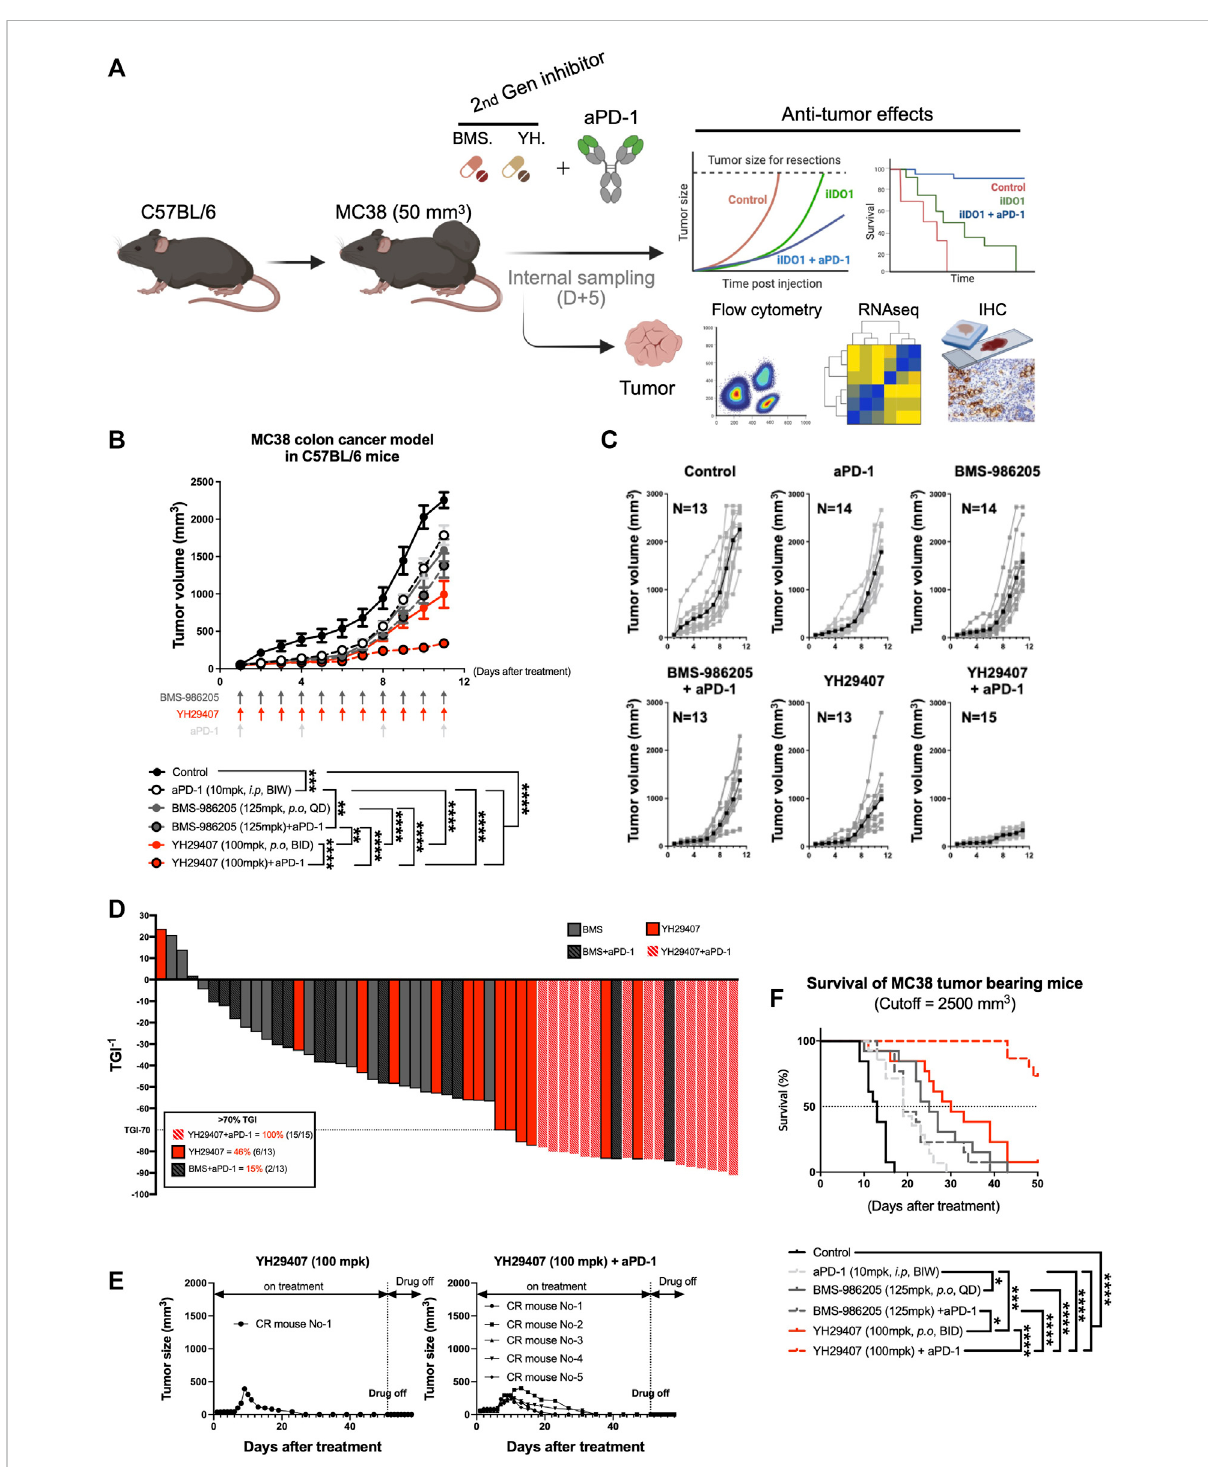
Combination treatment of YH29407 and aPD-1 delayed tumor growth and enhanced tumor growth inhibition and survival of syngeneic MC38 tumor-bearing model. Syngeneic MC38 colon tumor was grafted onto C57BL/6 mice and treatment of YH29407 with or without aPD-1 was started whenthe tumor volume reached 50 mm 3 . BMS-986205was treated as comparativedrugs, and thecontrol group was treated with avehicle. (A) Schematic design of experiment. (B) Combination treatment with YH29407 and aPD-1 signi fi cantly delayed MC38 tumor growth in